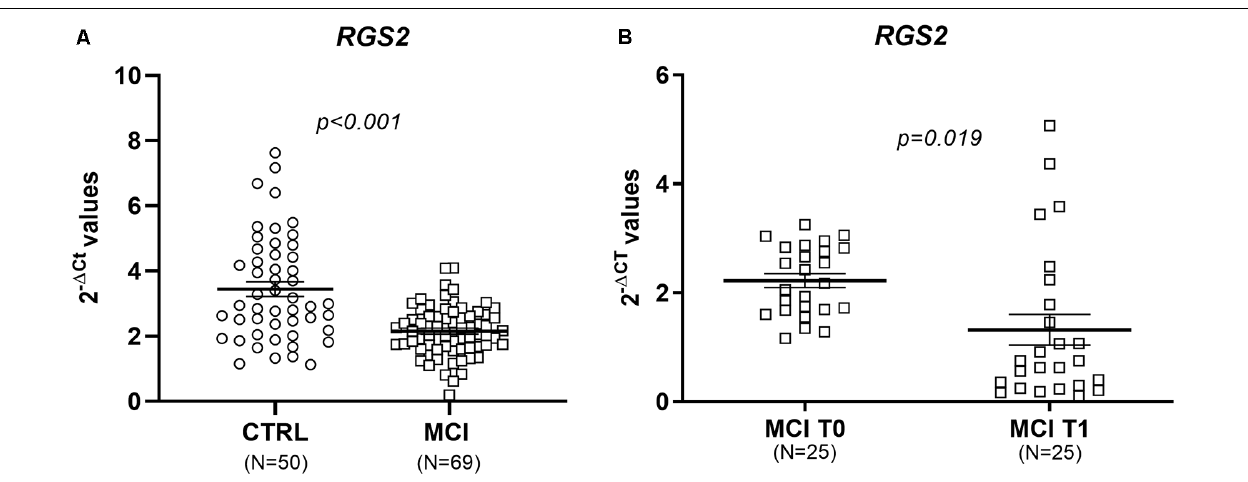
FIGURE 1 | (A) Reduced blood RGS2 mRNA levels in mild cognitive impairment (MCI) patients vs . non-cognitively impaired controls (CTRL); (FR = − 1.60). Data are presented as 2 − ∆ Ct values and bars represent the expression averages ± standard error of mean (SEM). The p -value was calculated using the Mann–Whitney U test. (B) Blood RGS2 mRNA levels in the sub-cohort of 25 MCI patients evaluated at baseline (T0) and after one year (T1) of therapy with rivastigmine or donepezil. Data are presented as 2 − ∆ Ct values and bars represent the expression average ± SEM. The p -value was calculated using the related samples Wilcoxon signed rank